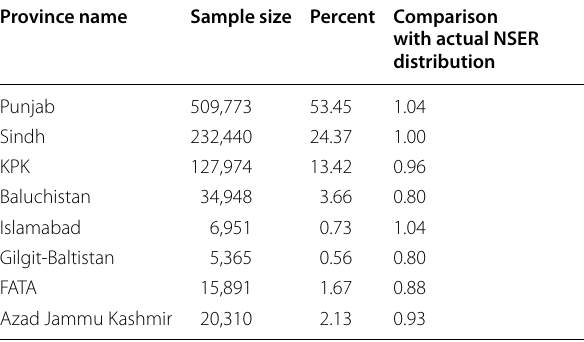
Table 1 Percentage NSER sample for provinces. Source : BISP,